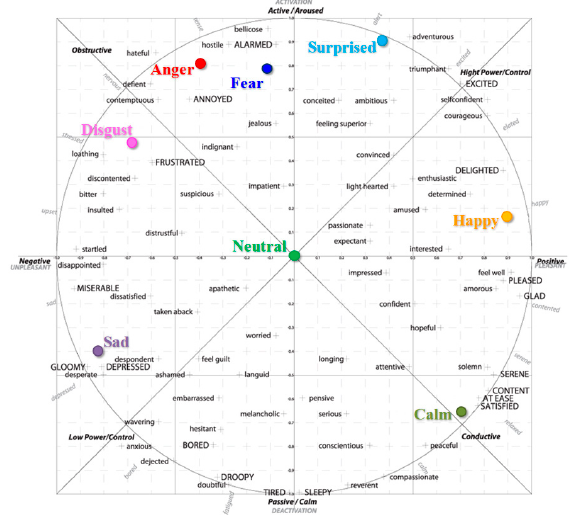
Figure 4. Emotion representation in the valence ‐ arousal space using Mikel’s wheel of emotions.